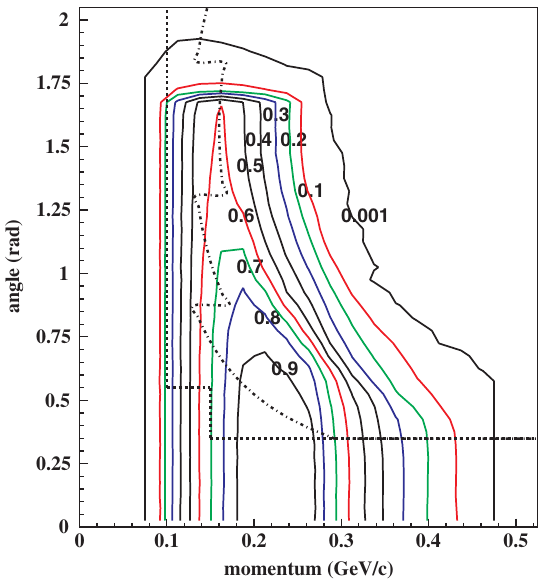
FIG. 3. Acceptance, A , of the NF/MC front-end channel, ex- pressed in terms of the kinematic variables of the pion as it exits the production target. The kinematic region analyzed by the HARP (HARP-CDP) collaboration is the region above and to the right of the thick dotted (solid) line.